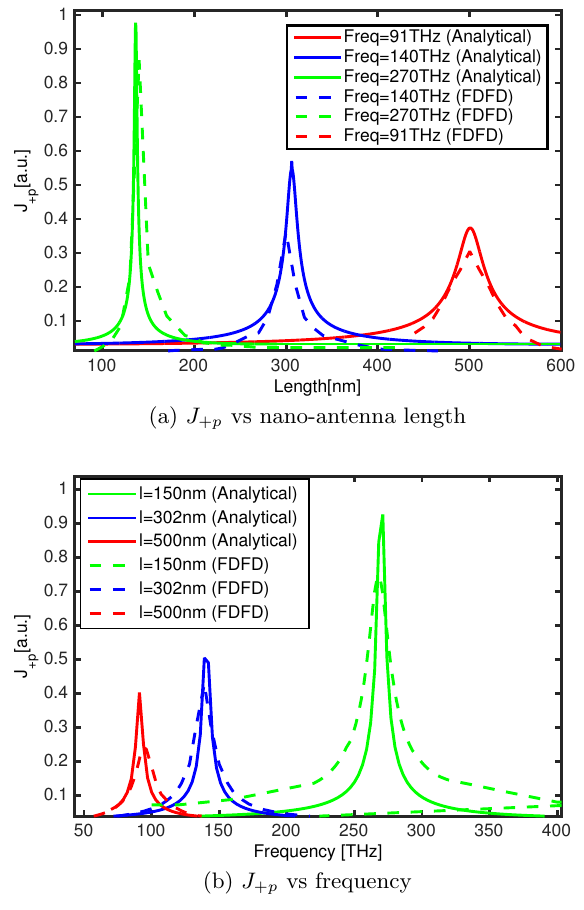
Figure 5: Plasmonic current density on a gold-based nano-antenna as a function of frequency and length (radius a =5